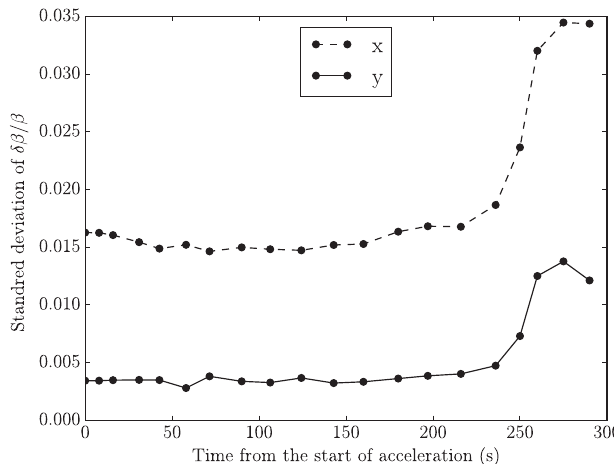
FIG. 4. The standard deviation of the resultant relative changes of the β -functions during the 280 second beam acceleration cycle with the dispersion primes matched at the two Siberian snakes in the